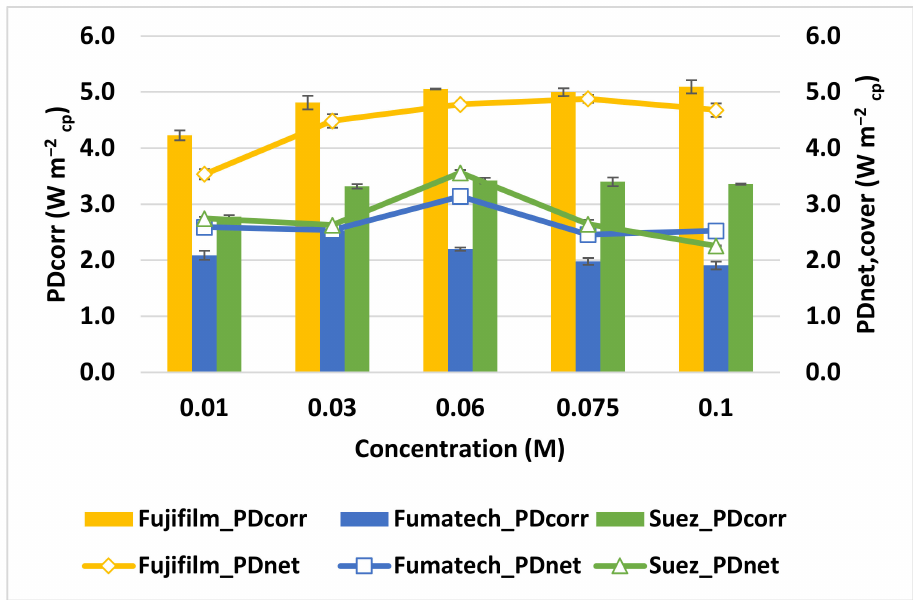
Figure 8. Influence of TDS concentration in the low salinity stream ( C Low ) on power density for the three different configurations. C High = 5 mol L − 1 , 20 ◦ C temperature and flows velocity 1 cm s − 1